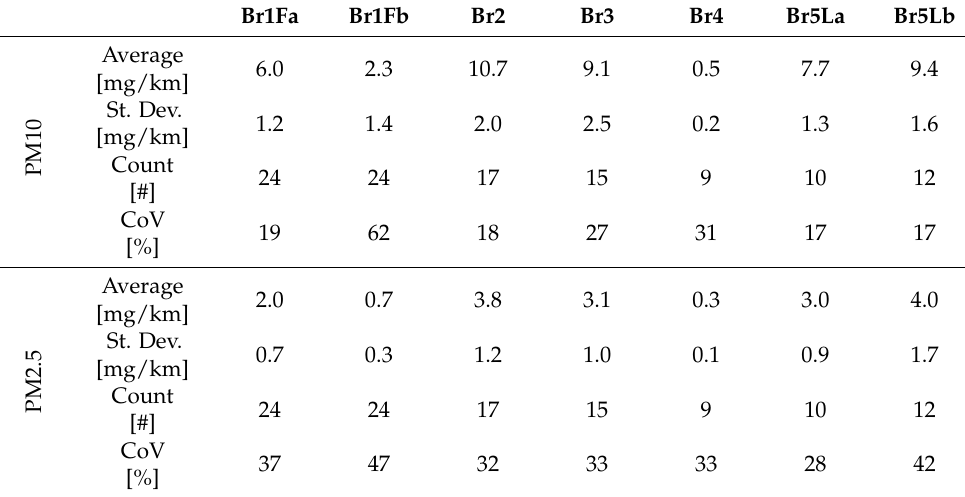
Table 10. PM10 and PM2.5 measurement reproducibility after data filtering. The row “count” denotes the number of emission tests used to calculate the